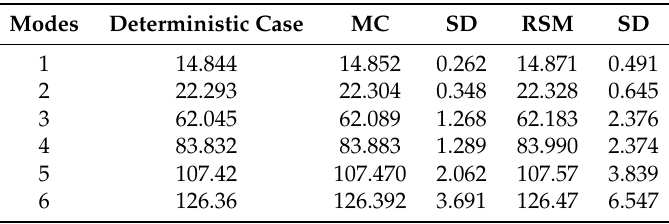
Table 5. Natural frequencies (Hz) of the wing. MC: Monte Carlo; RSM: response surface method; SD: standard